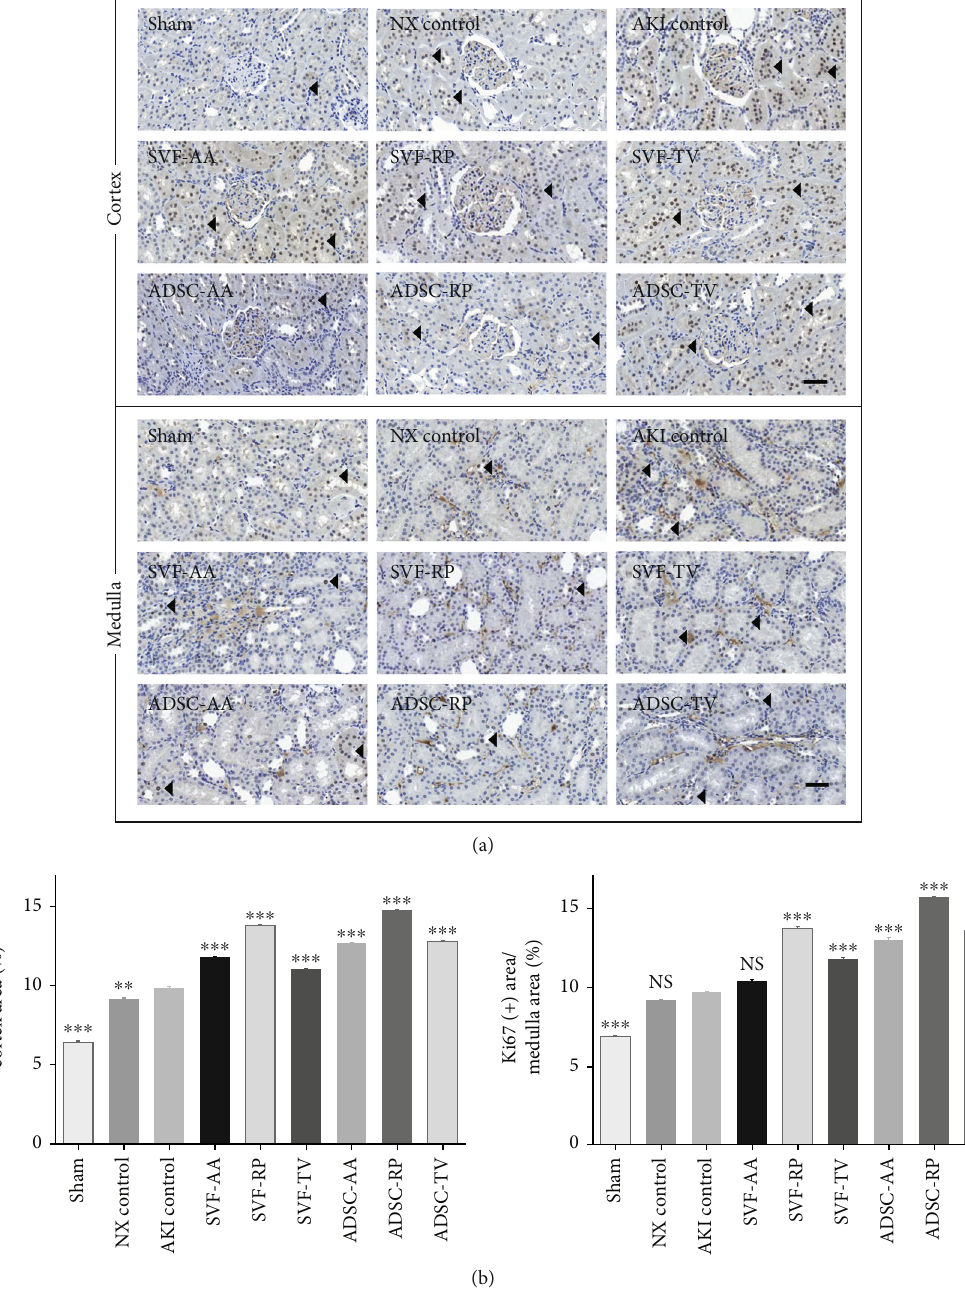
Figure 8: Proliferation marker of kidney tissue. (a) Representative photomicrographs of cortex and medulla. Arrowheads indicate nuclei stained positive for Ki67. (b) Ratio of area stained positive for Ki67 to random cortex area (left) and medulla area (right). Magni fi cation × 40. Scale bar 50 μ m. NS, p > 0 : 05 ; ∗∗ p < 0 : 01 ; ∗∗∗ p < 0 : 001 compared to the AKI control group. 4 fi elds per rat; 10 rats per group, but 8 rats in the SVF-AA and ADSC-AA